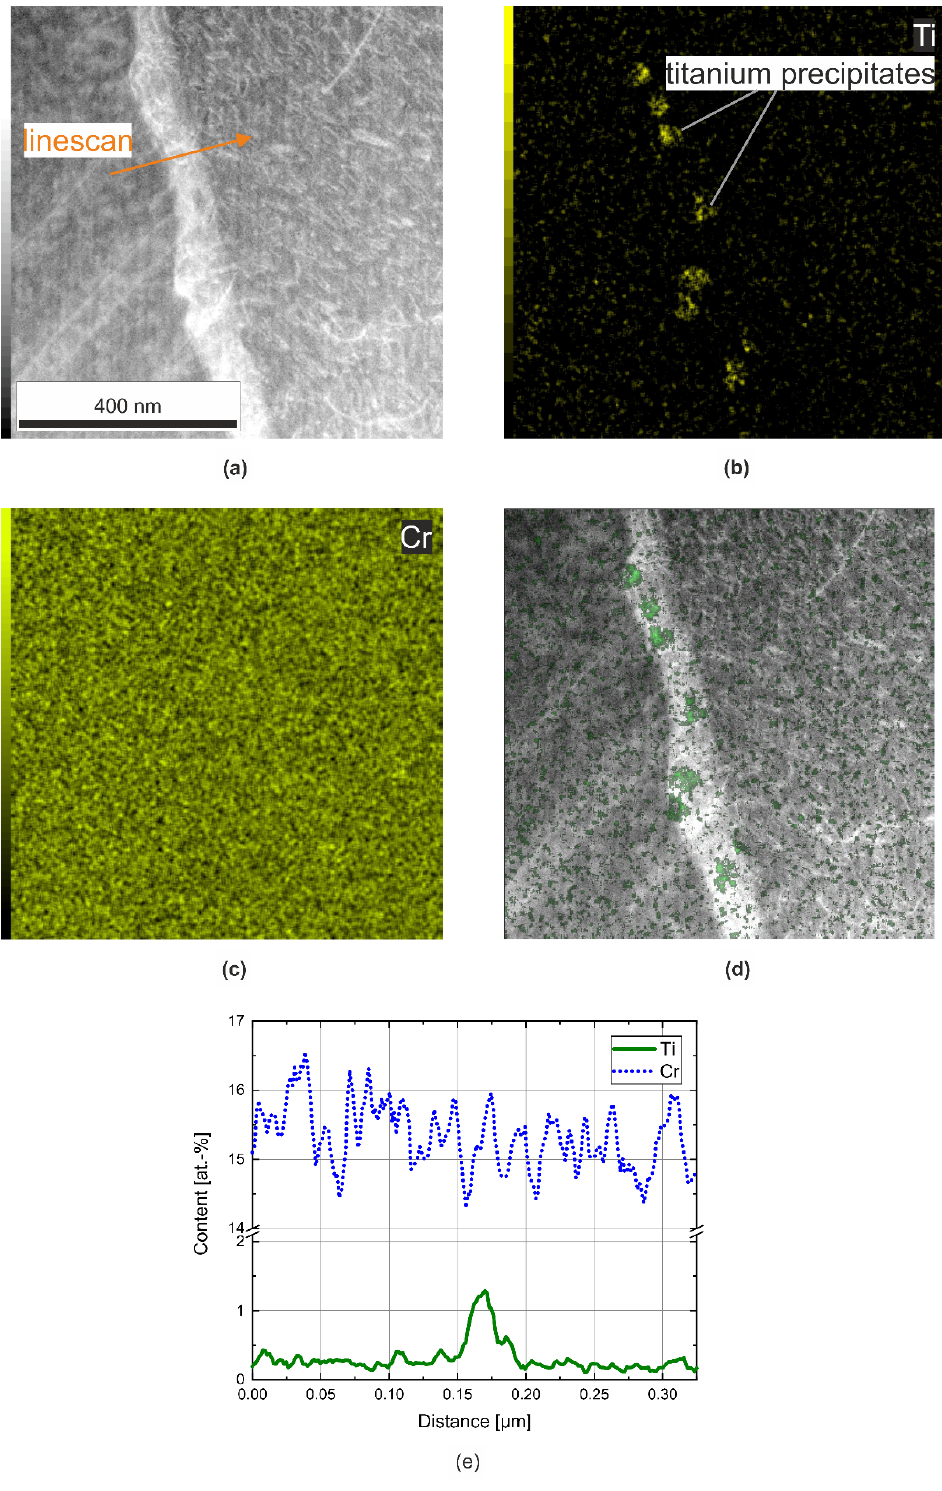
Figure 4. ( a ) HAADF-image of investigated grain boundary region within weld metal of AISI 430Ti with EDS-maps for ( b ) titanium and ( c ) chromium. ( d ) shows an overlay of Ti-EDS-map and HAADF image, ( e ) represents results of the EDS-line